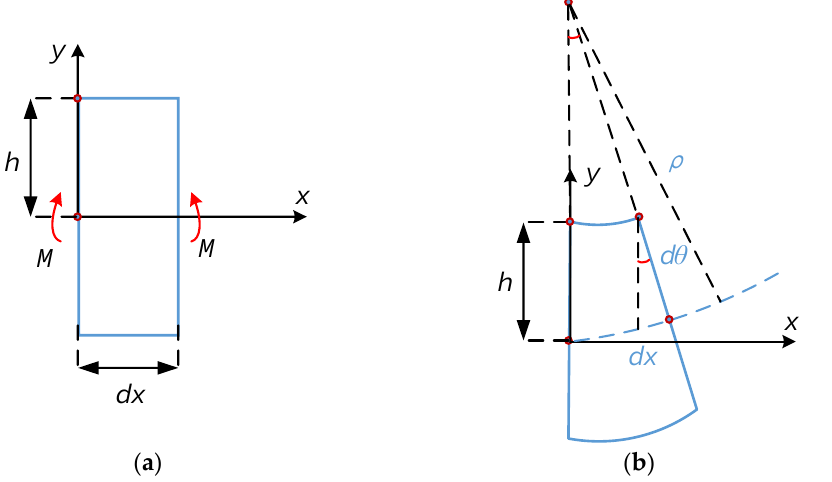
Figure 4. Deformation of micro-segment beam: ( a ) micro-segment of a beam; and ( b ) deformation diagram.